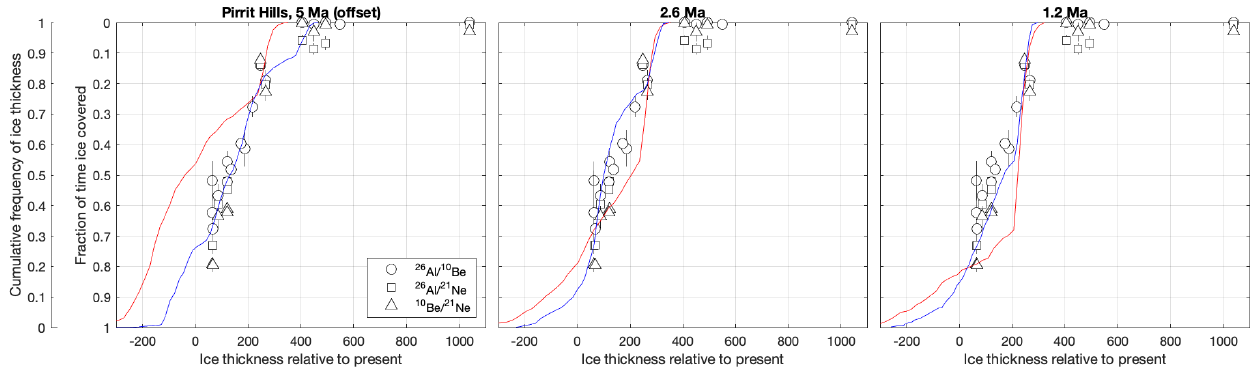
Figure 10. The data in this figure are the same as in Fig. 9, but the model ice thickness CDFs are offset in order to align observed and model CDFs at the 80th percentile of ice